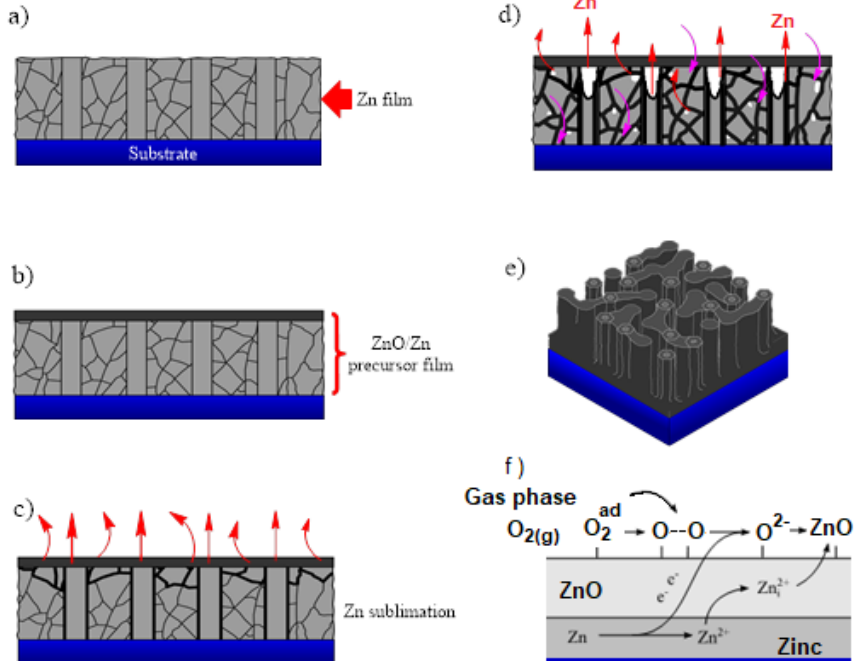
Figure 7. Scheme of the proposed mechanism during the formation of nanoporous ZnO films through the sublimation of Zn from the ZnO/Zn precursor film.